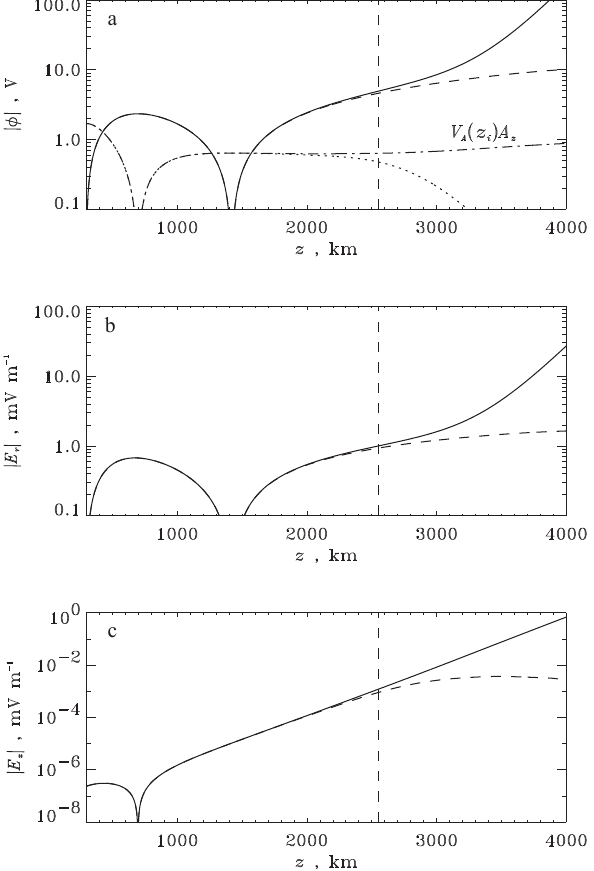
Fig. 7. Variation with height of ( a ) the scalar/vector potential shown for two cases: α 1 6= 0 (solid/dashed-dotted line) and α 1 = 0 (dashed/dotted line); ( b ) the amplitude of the transverse electric field | E r | : α 1 6= 0 (solid line), α 1 = 0 (dashed line); ( c ) the par- allel electric field | E z | : α 1 6= 0 (solid line), α 1 = 0 (dashed line). Location of the FAST spacecraft is indicated by the vertical dashed line.